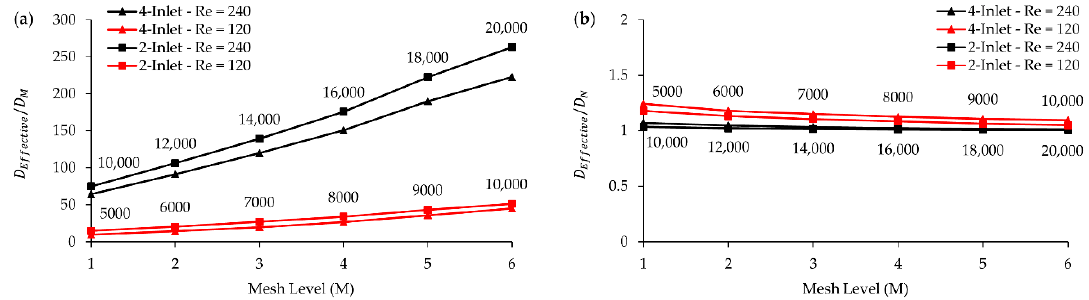
Figure 14. Normalized effective diffusivity vs. mesh levels: ( a ) D Effective / D M and ( b ) D Effective / D N . The numbers above the trend lines show average Pe ∆ numbers for mesh levels and flow scenarios.